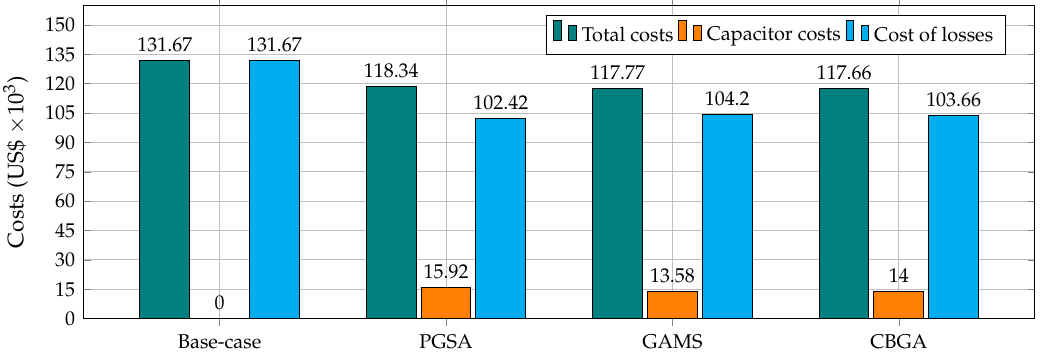
Figure 7. Discriminated costs for the 10-node test feeder.